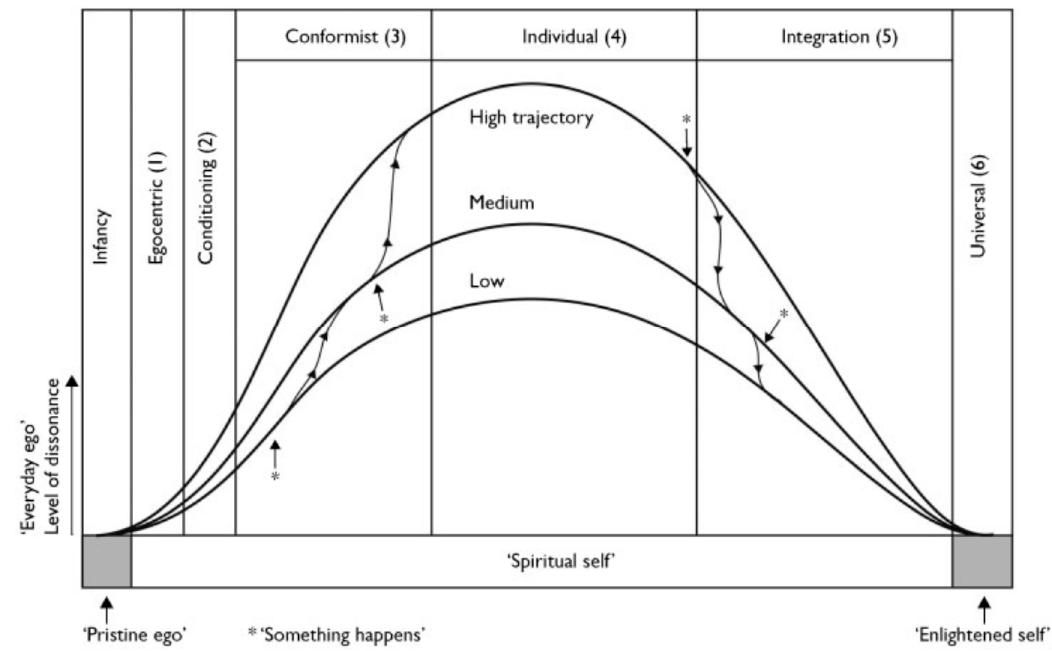
Figure 1. The Meaning of Life Diagram [28] (p. 29).